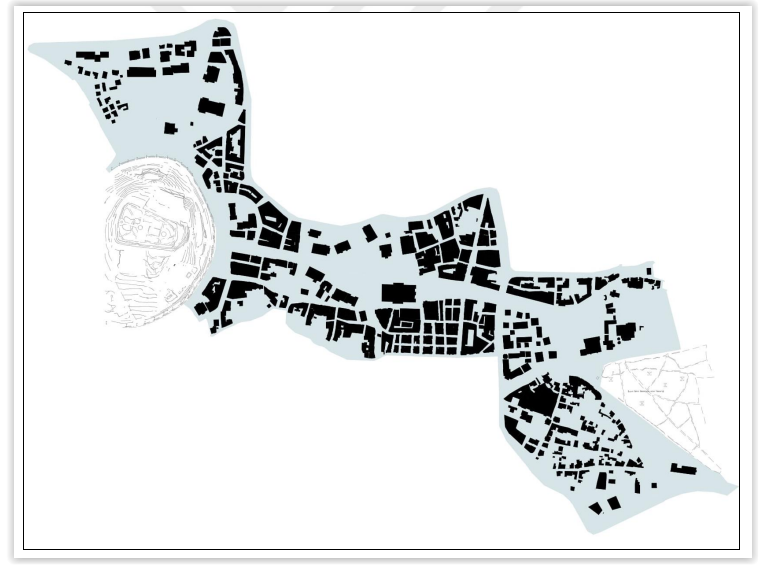
Figure 9 The figure-ground map of Konya historical city center research area (Ünal,